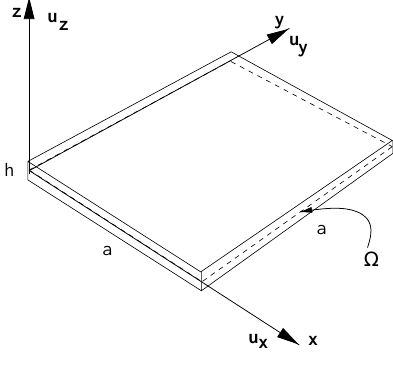
Fig. 1. Geometry and